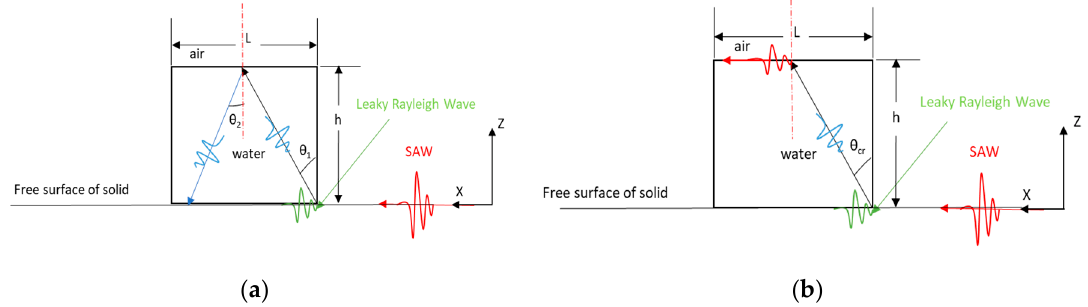
Figure 1. ( a ) Schematic representation of a wave traveling in the liquid when the reflected angle at the solid–liquid interface is larger than the critical angle; ( b ) Schematic representation of a wave traveling in the liquid when the reflected angle at the solid–liquid interface is equal to the critical reflected angle.